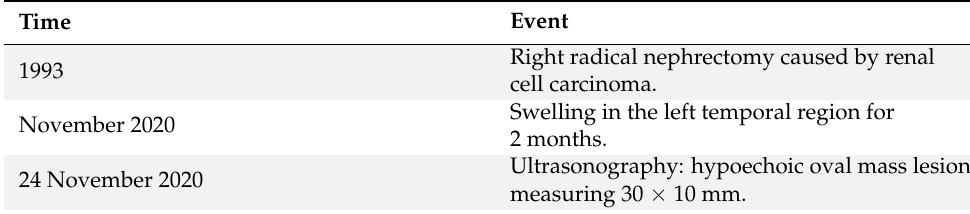
Table 1. Timeline of patient’s medical